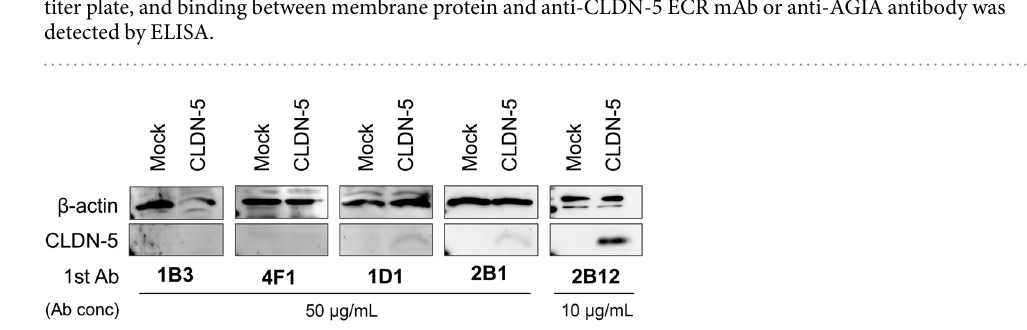
Figure 5. Binding of anti-CLDN-5 antibody to denatured human CLDN-5. Denatured CLDN-5 was detected by western blotting using anti-CLDN-5 ECR mAbs as primary antibody. Lysates of mock or human CLDN-5–expressing cells were subjected to SDS-PAGE. Blotted membranes were incubated with 10 µ g/mL 2B12 or 50 µ g/mL the other anti-CLDN-5 ECR mAbs. Regions of CLDN-5 band and β -actin band as a loading control were cropped from original blotting images. Full-length blotting images are shown in Supplementary Fig. S2.